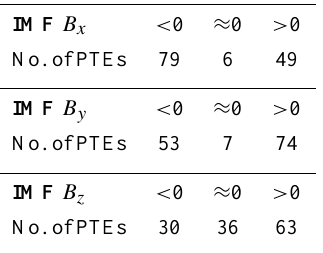
Table 2. Summary of PTEs for different IMF